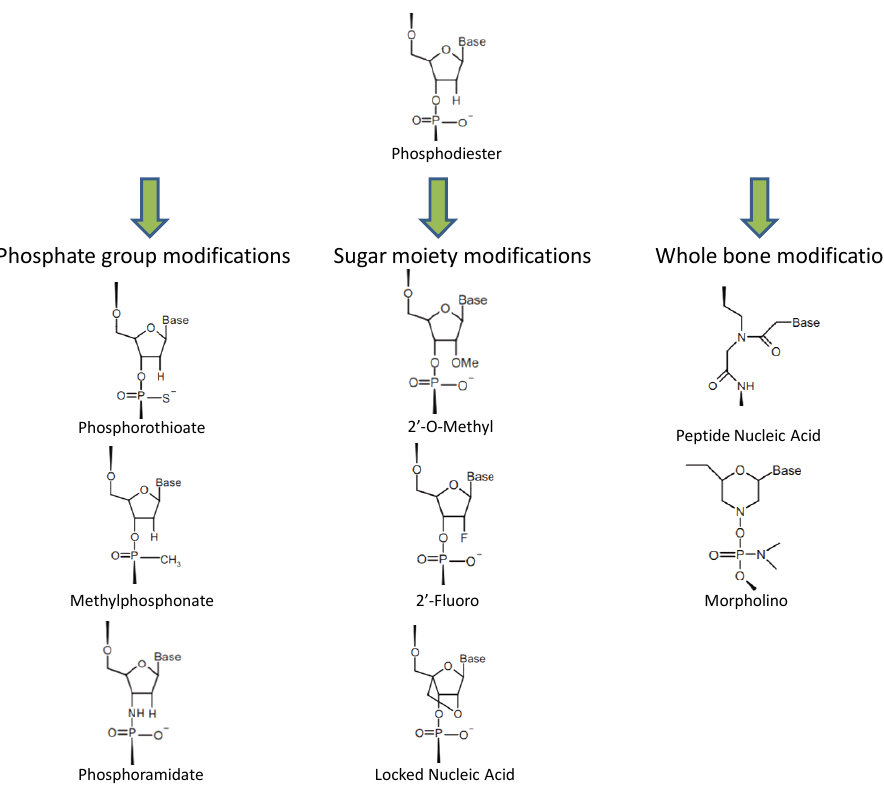
Figure 1. The main chemically modified antisense